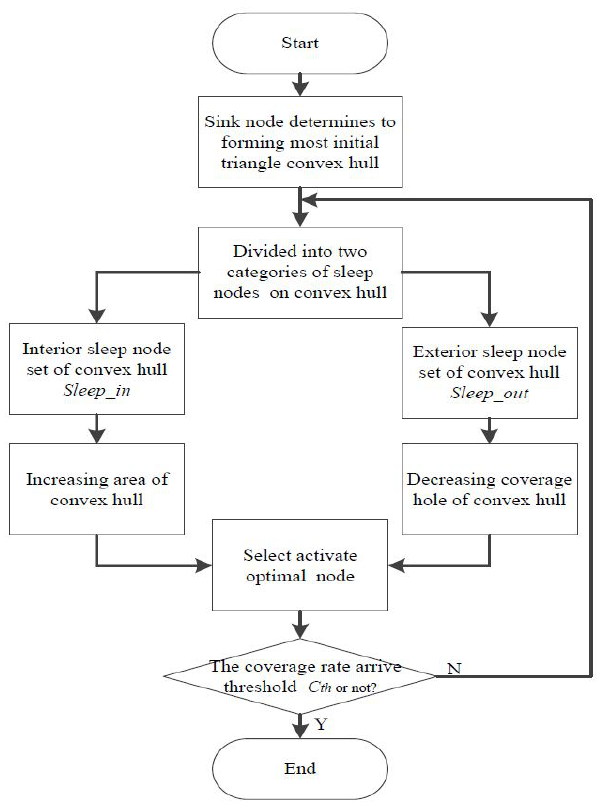
Figure 6. Flowchart of the optimal activation